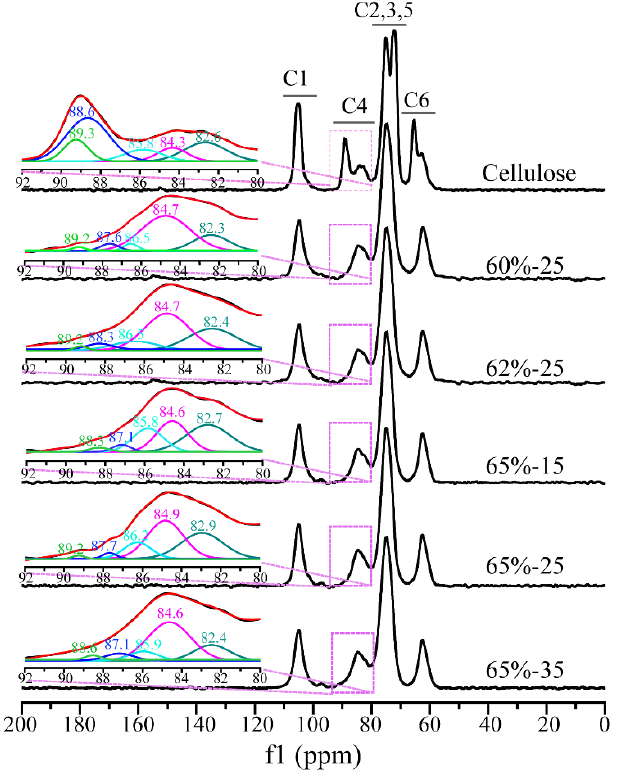
Figure 2. Cross-polarization magic-angle spinning carbon-13 nuclear magnetic resonance (CP/MAS 13 C NMR) spectra of cellulose samples. 13 C NMR) spectra of cellulose